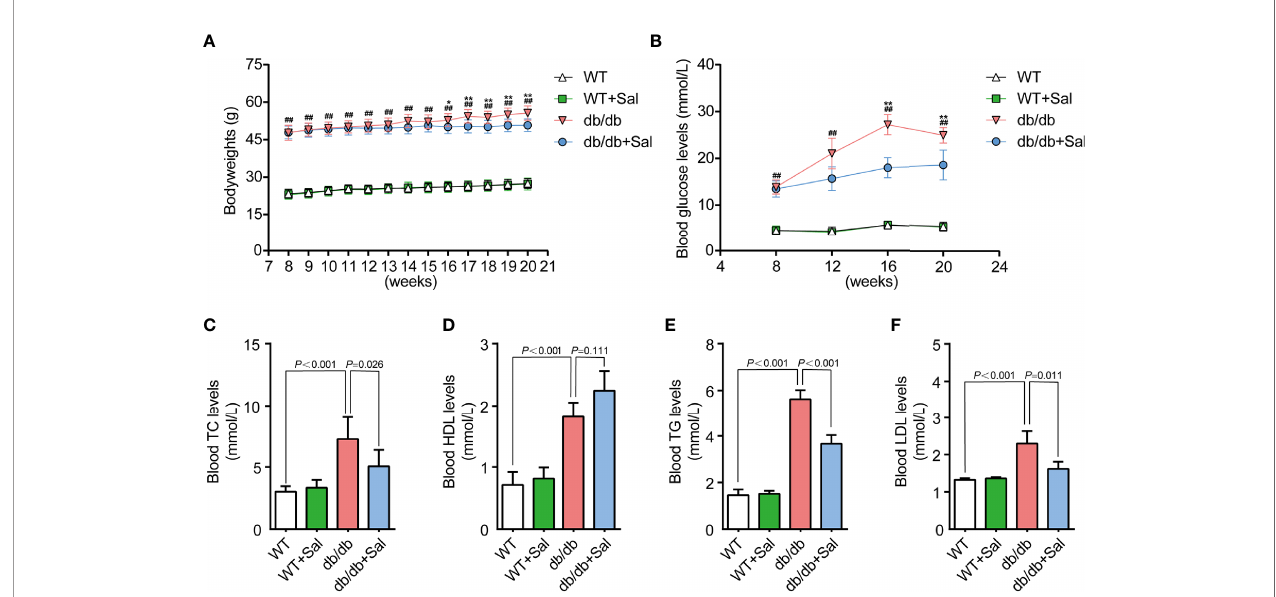
FIGURE 1 | Sal improved blood glucose and lipid pro fi les in db/db mice. (A) The bodyweight of WT and db/db mice after Sal intervention. (B) The blood glucose of WT and db/db mice after Sal intervention. (C-F) The blood levels of total cholesterol (TC), high density lipoprotein (HDL), triglyceride (TG) and low density lipoprotein (LDL) in WT and db/db mice after Sal intervention. Data are the mean ± SD; ## p < 0.01 (db/db mice compared with WT mice), *p < 0.05, **p < 0.01 (db/db + Sal mice compared with db/db